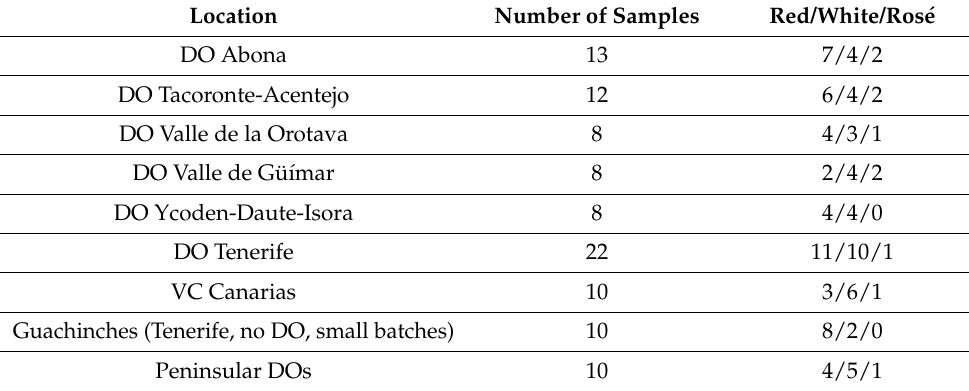
Table 2. Summary of wine samples per